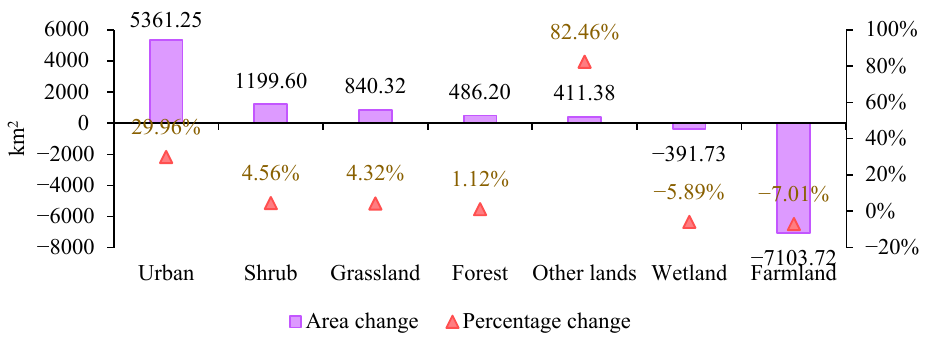
Figure 4. Area changes and area change ratios of ecosystems in the Beijing–Tianjin–Hebei urban agglomeration from 2000 to 2015.